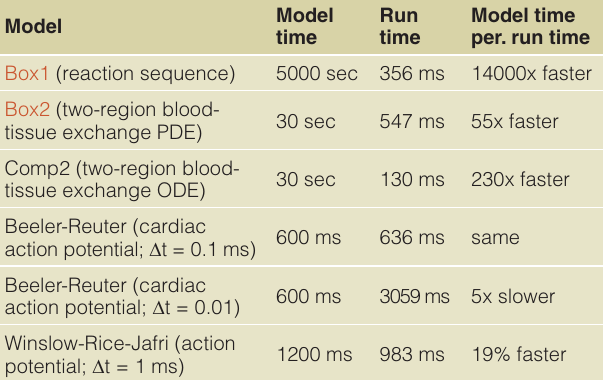
Table 5. Solution Times for Some Models.